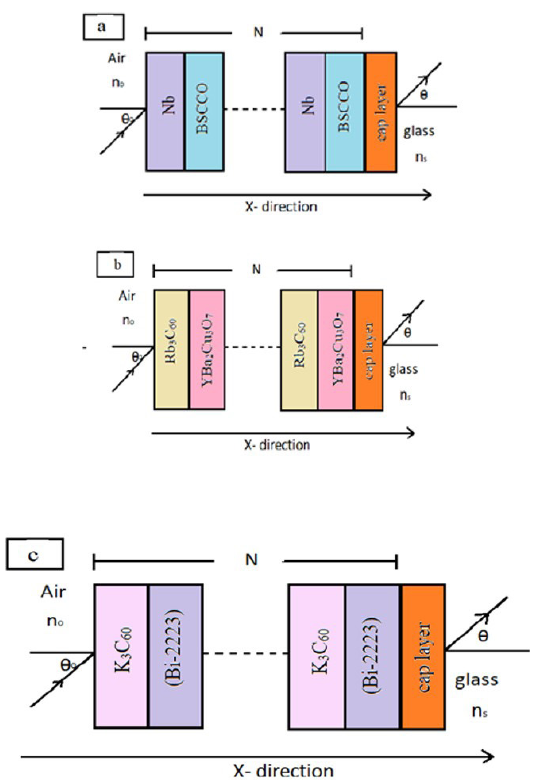
Figure 1. A Schematic diagram of the three proposed 1D periodic structures with different superconductor materials and delimited by dielectrics cap layers. Where a) BSCCO; b) YBa in c)